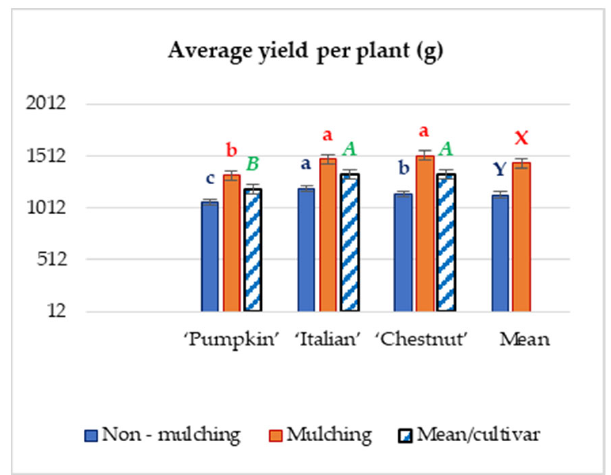
Figure 1. Effect of the cultivar on the production parameters of marketable sweet potato tubers; average yield per plant (g). Bars represent standard error. Means followed by same letter are not significantly different (Tukey’s multiple range test, p < 0.05).